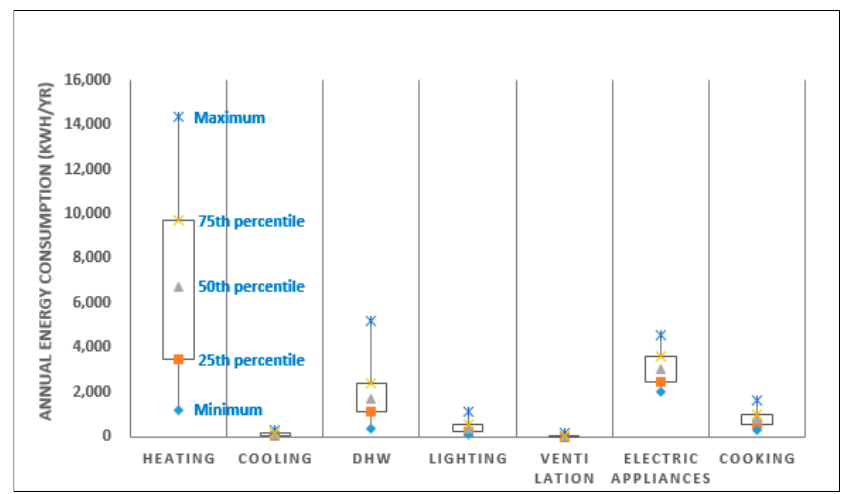
Figure 5. Annual energy consumption by end use.